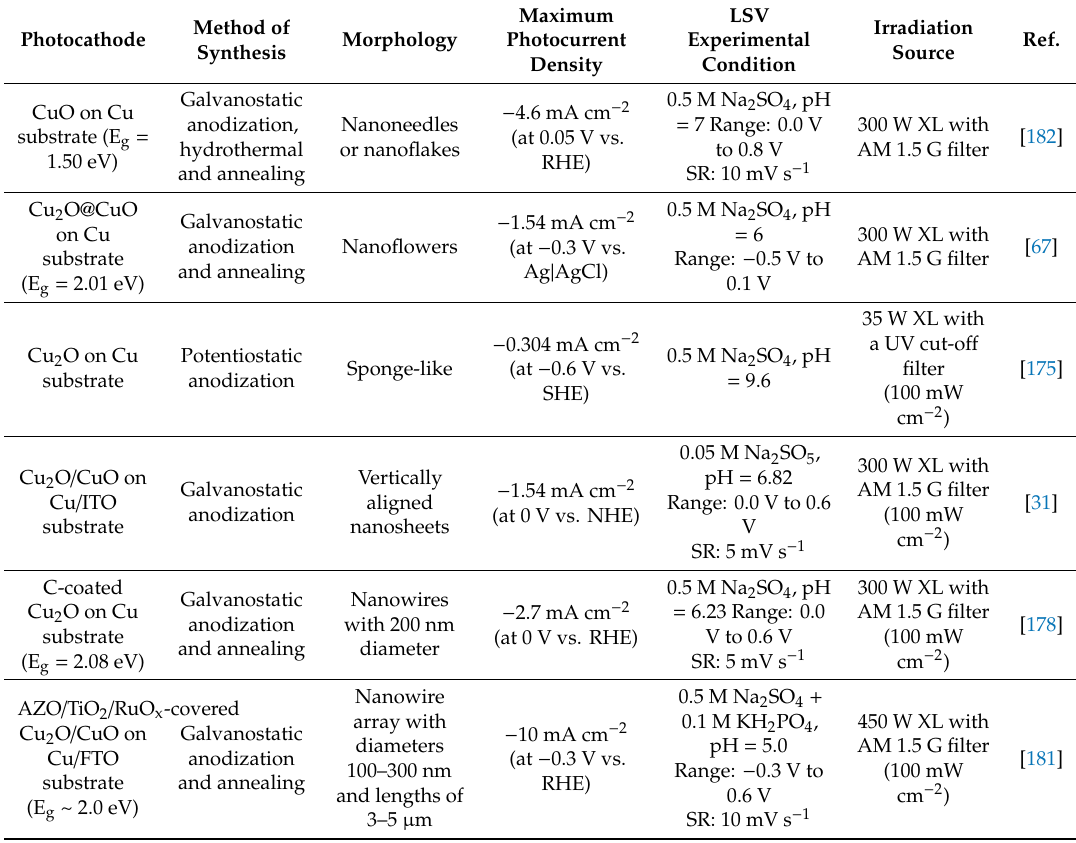
Table 4. Photocathode architectures based on anodized copper oxides and maximum photocurrent densities obtained under experimental conditions